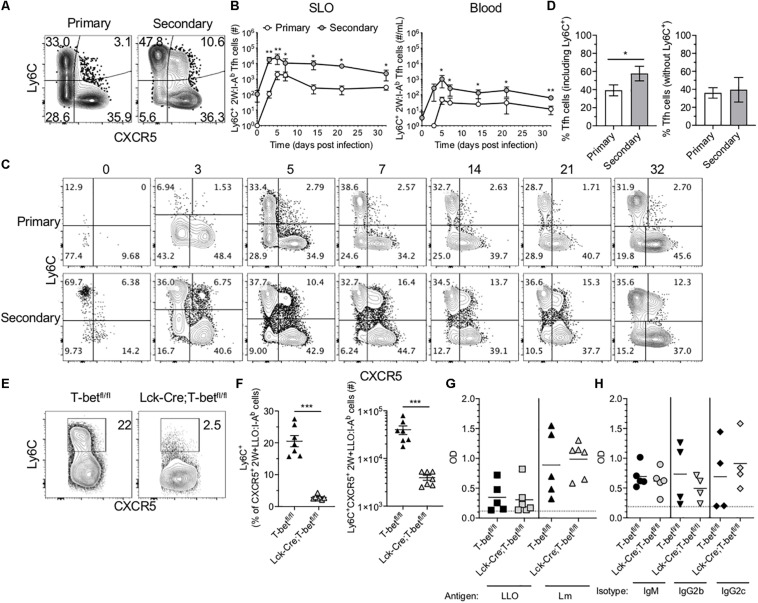
Ly6C+ Tfh cells expand during the secondary response and require T-bet. (A) Representative flow cytometry plots demonstrating CXCR5 and Ly6C expression on 2W:I-Ab-specific CD4+ T cells, excluding Foxp3+ Tregs, in the SLOs at 5 dpi following primary or secondary Lm infection. (B) Number of Ly6C+ Tfh cells in SLO and blood. (C) Representative flow cytometry plots of CXCR5 and Ly6C expression on 2W:I-Ab-specific cells, excluding Foxp3+ Tregs, in the SLOs at 0, 3, 5, 7, 14, 21, and 32 dpi following primary or secondary Lm infection. (D) Frequency of Tfh cells in the SLOs at 14 dpi including or excluding Ly6C+ cells. (E) Representative flow cytometry plots demonstrating Ly6C expression on 2W + LLO:I-Ab-specific CXCR5+ Tfh cells in the SLOs following secondary Lm infection of T-betfl/fl or Lck-Cre;T-betfl/fl mice at 5 dpi. (F) Frequency and number of Ly6C+ Tfh cells as shown in panel (E). (G) ELISA data assessing the presence of anti-LLO or anti-Lm IgG antibodies in the serum of T-betfl/fl or Lck-Cre;T-betfl/fl mice following secondary Lm infection at 10 dpi. (H) ELISA data assessing the presence of anti-Lm IgM, IgG2b or IgG2c antibodies as in panel (G). Data are compiled from two to three independent experiments per time point with n = 1–4 mice per experiment (A–D) or from two independent experiments with n = 2–4 mice per group per experiment (E–H). *P < 0.05, **P < 0.01, ***P < 0.001, ****P < 0.0001 as determined by unpaired Student’s t-test (D,F) or Mann Whitney U test (B). Bars represent mean ± SEM (D,F) or mean ± SD (B).